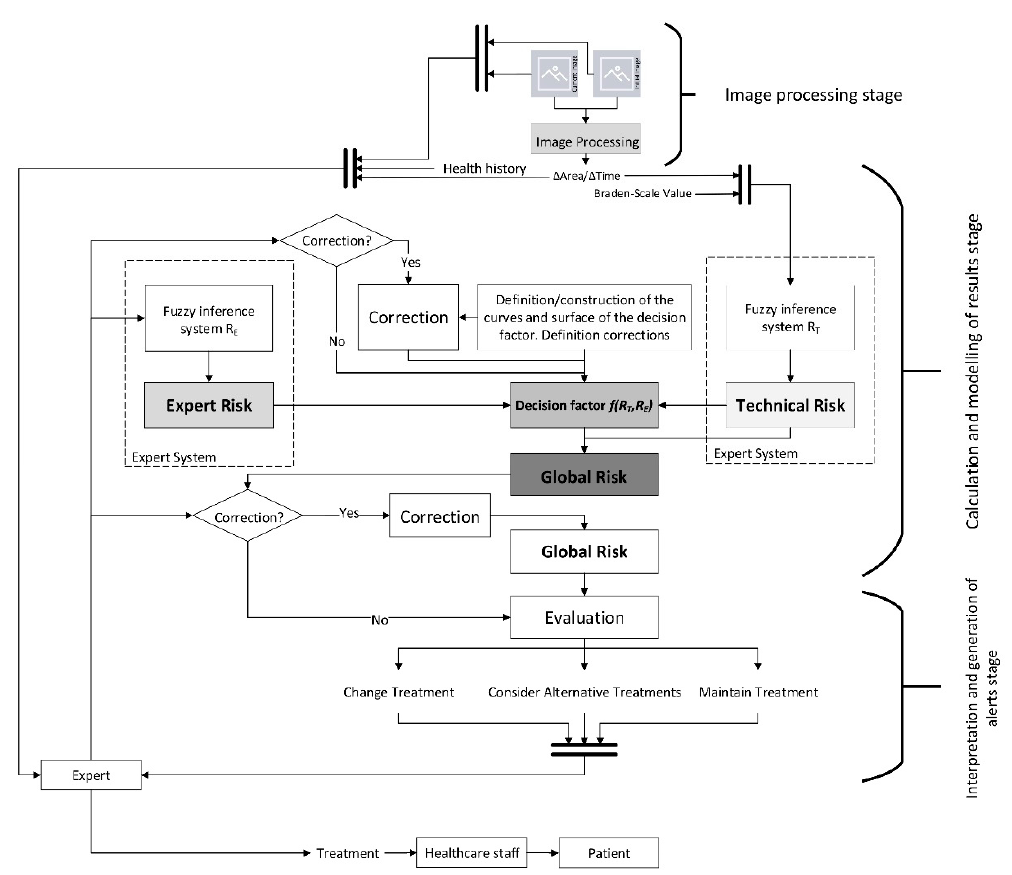
Figure 5. Flow chart of the system’s operation.